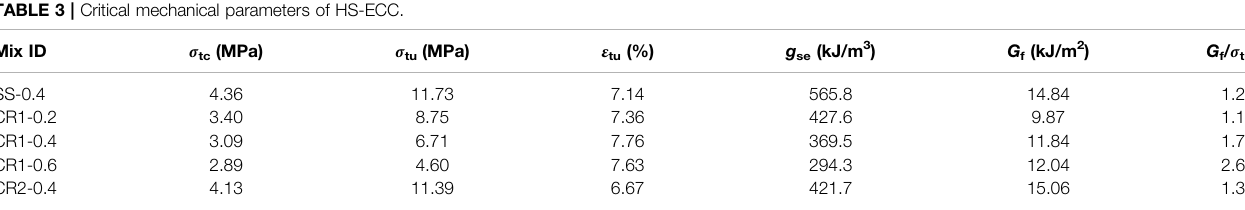
TABLE 3 | Critical mechanical parameters of